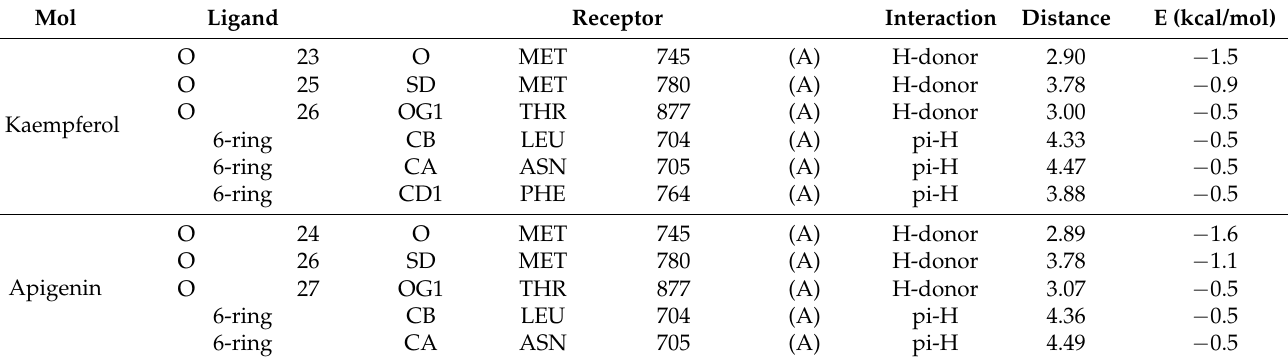
Table 6. Interaction of kaempferol and apigenin with Prostate Cancer (2Q7L)